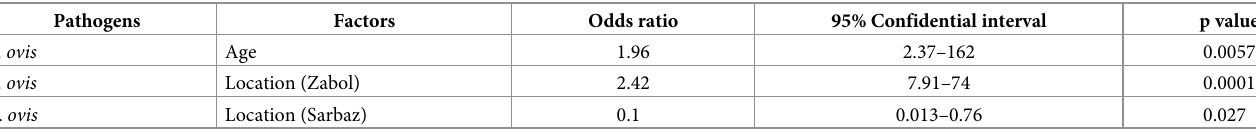
Table 4. Multivariate logistic regression analysis of the factors associating with the infection. Pathogens